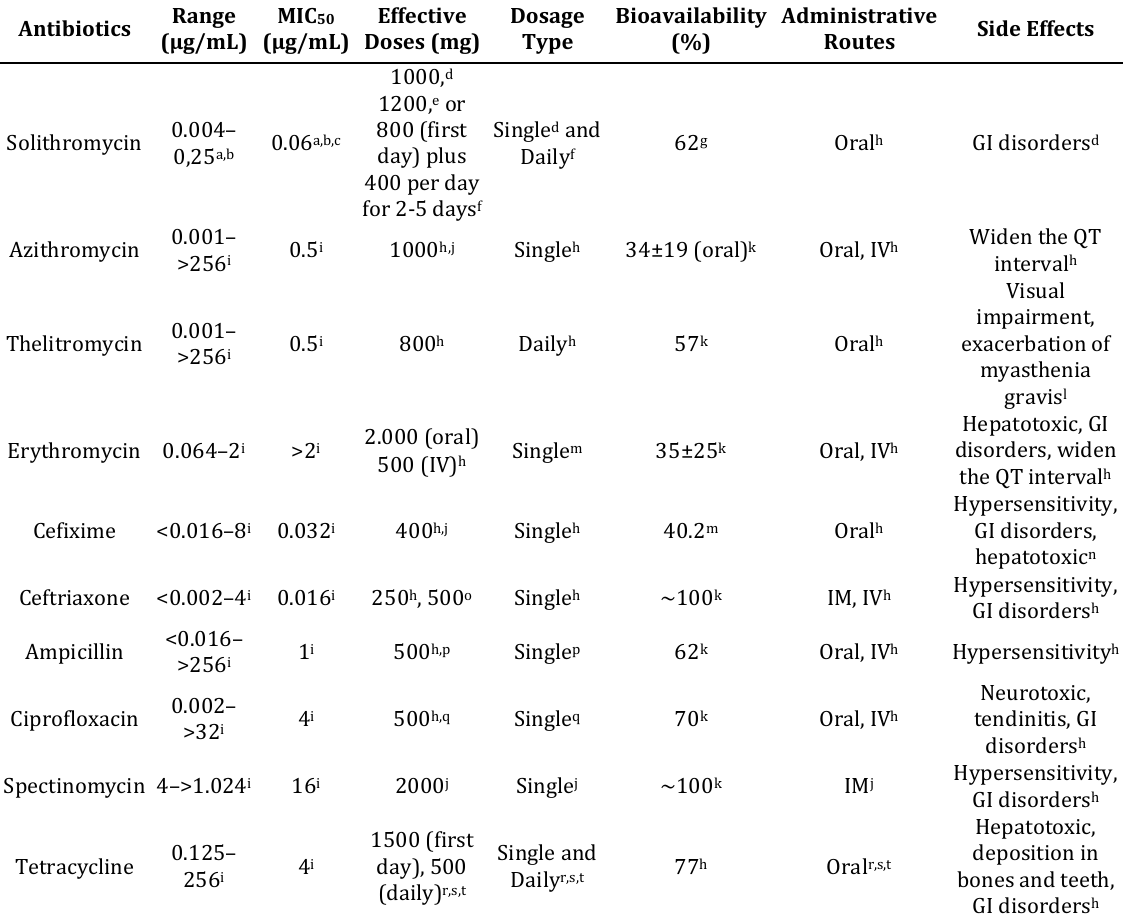
Table I. A comparison of pharmacology and pharmaceutical aspects of multiple antibiotics in treating of GO